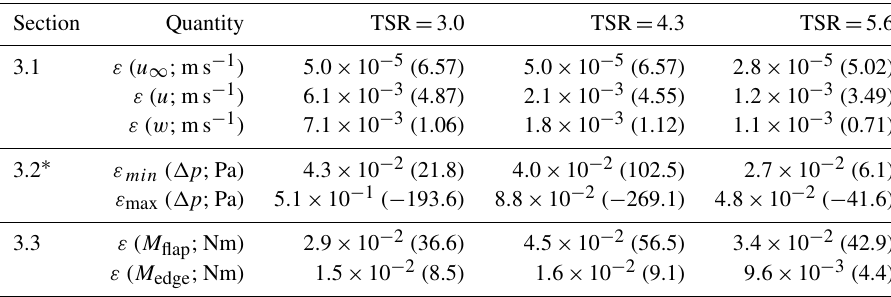
Table B2. The 95% confidence interval and reference values in brackets.